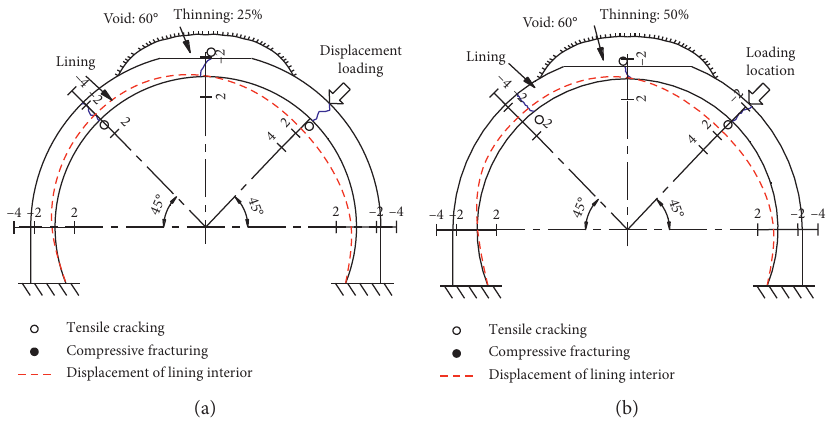
Figure 18: Distributions of lining cracking and deformation at the peak load (defects at the crown, displacement unit: mm): (a) V60T25 and (b) V60T50.